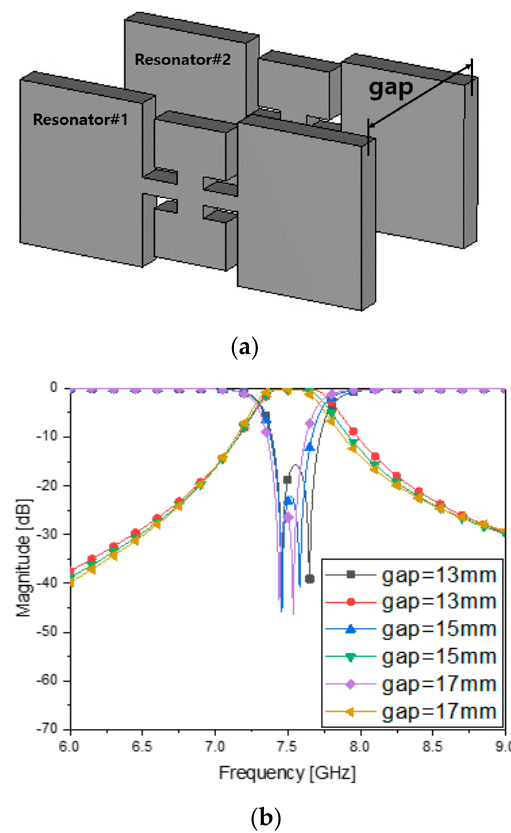
Figure 5. Combining two ZORs through the gap for coupling. ( a ) Structure. ( b ) S 11 and S 21 vs. gap. Table 5. The values of the physical dimensions of the second-order filter. Variable Value